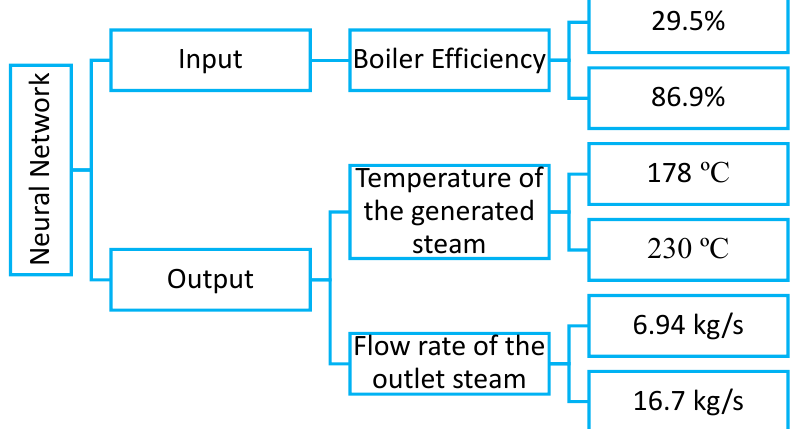
Figure 1. Figure 1. The upper and lower limit of input and output data for the construction of a neural network model.